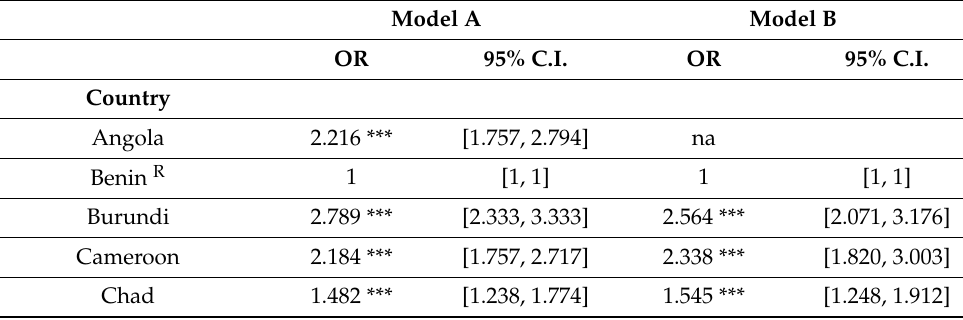
Table 5. Multivariate logistic regression model on severe